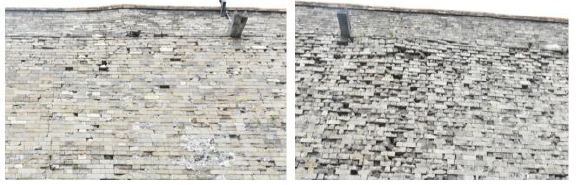
Figure 1. Bulge of the ancient